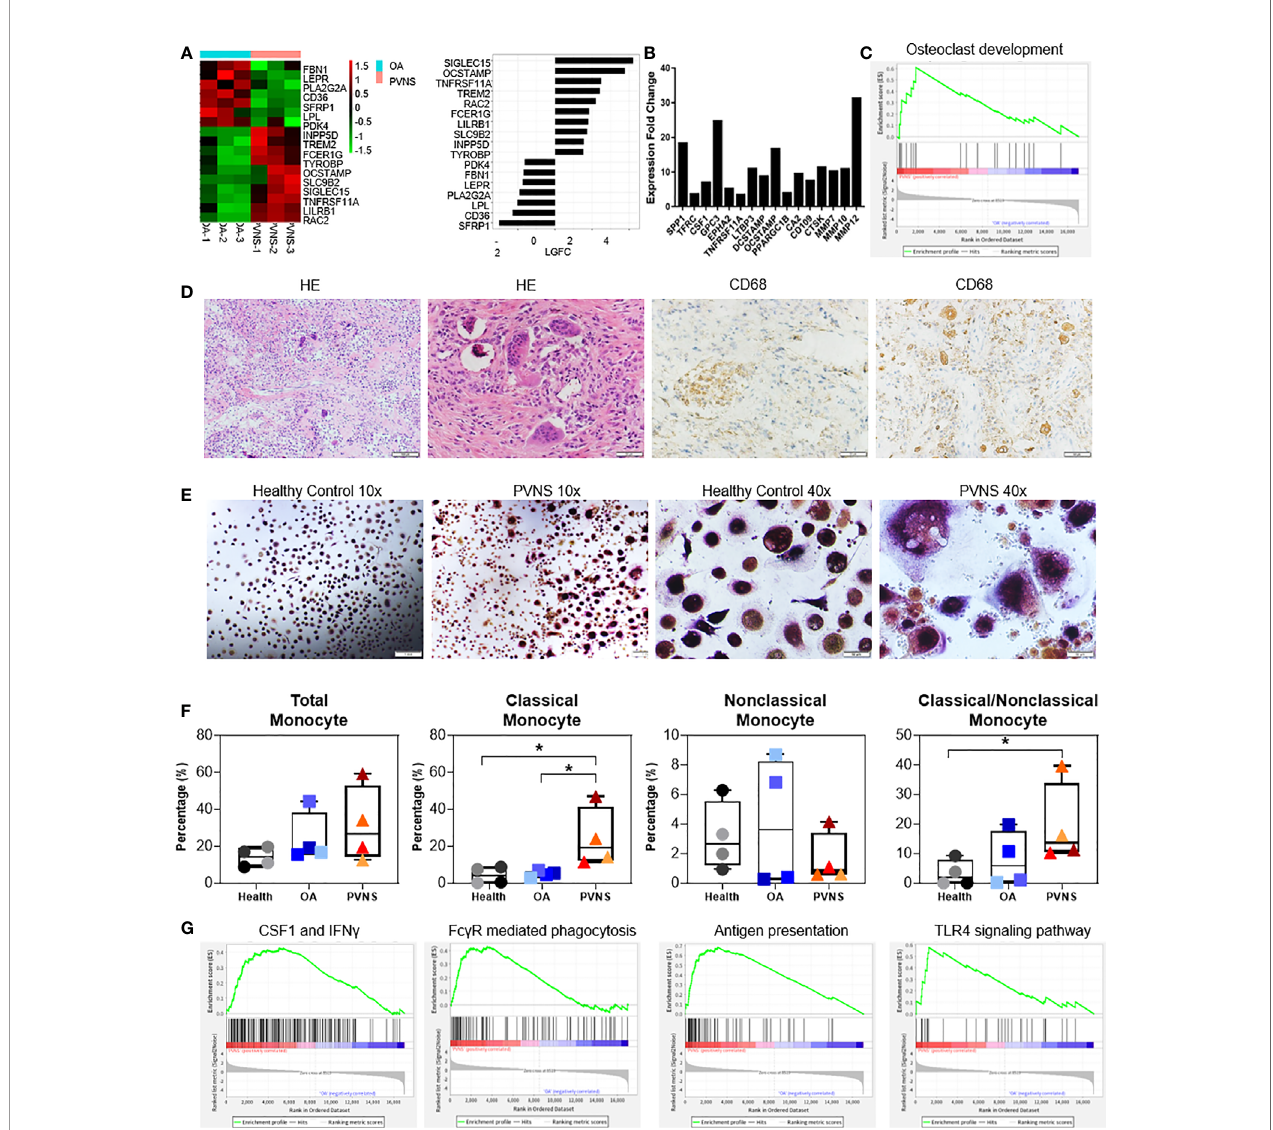
FIGURE 5 | Upregulated osteoclastogenesis-related genes in pigmented villonodular synovitis (PVNS) (A) Heatmap showing the gene expression between PVNS and osteoarthritis (OA) for osteoclast subnetwork. Fold change of representative differentially expressed genes (DEGs) were also shown. (B) Real-time quantitative polymerase chain reaction assay for the representative D.E.G.s to validate the result of functional enrichment analysis. Data in the bar graphs are presented as the means and standard deviations of three independent experiments. One-sample t-test was applied to the fold induction. (C) Gene set enrichment analysis (GSEA) plot depicting the enrichment of DEGs associated with osteoclast development in PVNS synovium ( p -value < 0.05). (D) Hematoxylin and eosin staining and immunohistochemical staining for CD68 in PVNS synovium. (E) CD14 + monocytes were isolated from PVNS or OA synovium and stimulated with macrophage colony stimulating factor and receptor activator of nuclear factor kappa B ligand for 10 days. Representative pictures of tartrate-resistant acid phosphatase staining to detect osteoclast differentiated from monocytes. (F) The percentage of total monocyte (CD45 + CD11b + CD14 + ), classical monocytes (CD14 ++ CD16 − ), and nonclassical monocytes (CD14 ± CD16 + ) in synovium from healthy subjects (n=4), OA patients (n=4), and PVNS patients (n=4). One-way ANOVA (Druskal-Wallis test) was applied to the multiple comparisons. * p -value < 0.05. (G) GSEA plot depicting the enrichment of DEGs in CSF1 and IFN-treated, Fc receptor mediated phagocytosis, antigen presentation, and toll-like receptor 4 signaling pathway in PVNS synovium ( p -value <